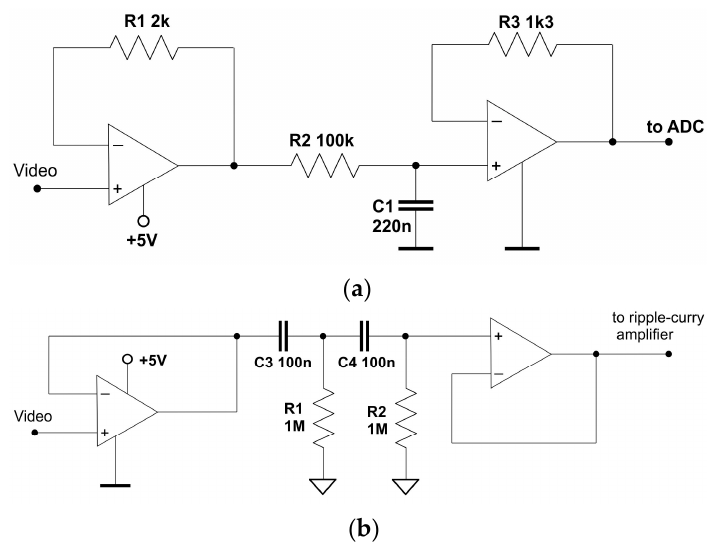
Figure 12. Video signal filters: ( a ) DC low-pass filter; ( b ) AC high-pass filter.